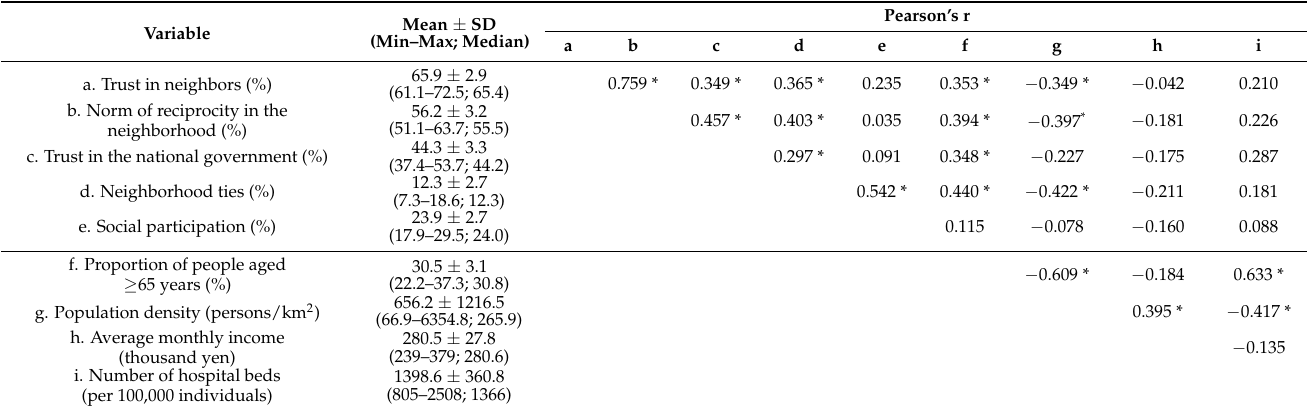
Table 2. Descriptive statistics of social capital and covariates and their correlations.